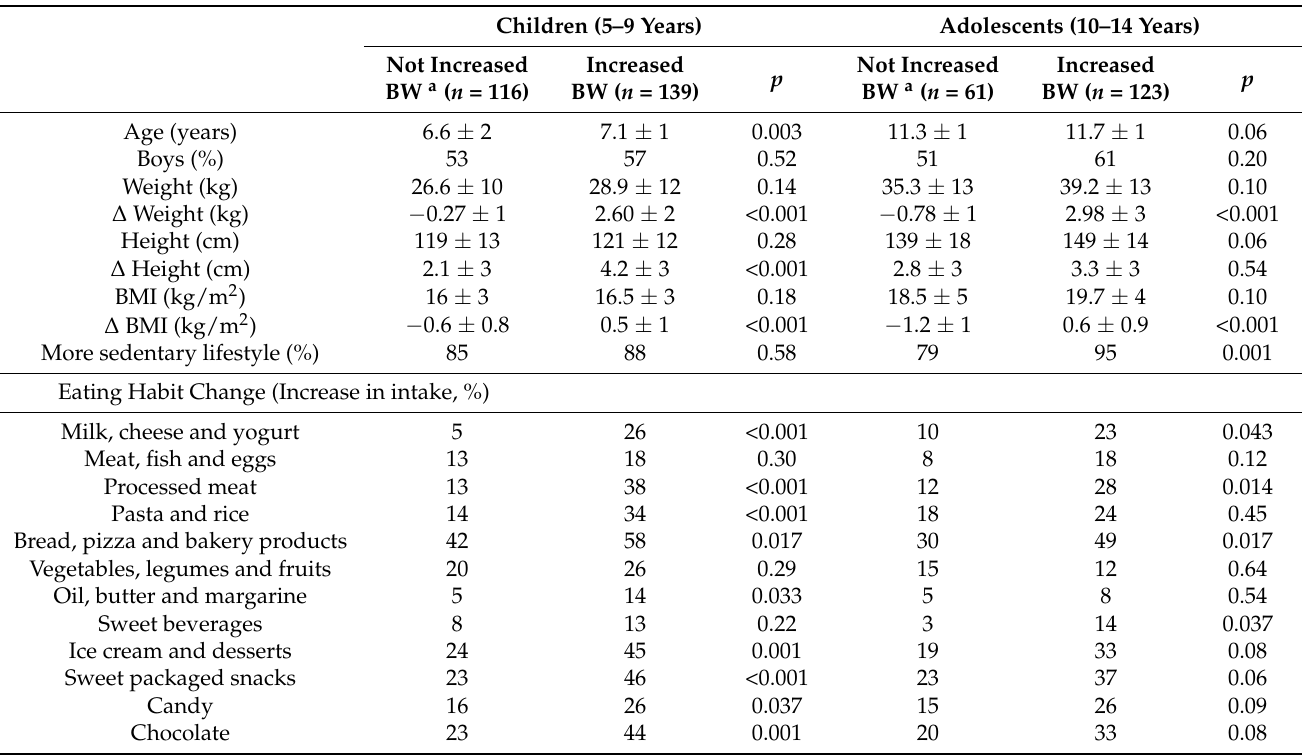
Table 2. Variation of anthropometric characteristics, lifestyle and eating habits of children and adolescents according to the change in body weight during the first COVID-19